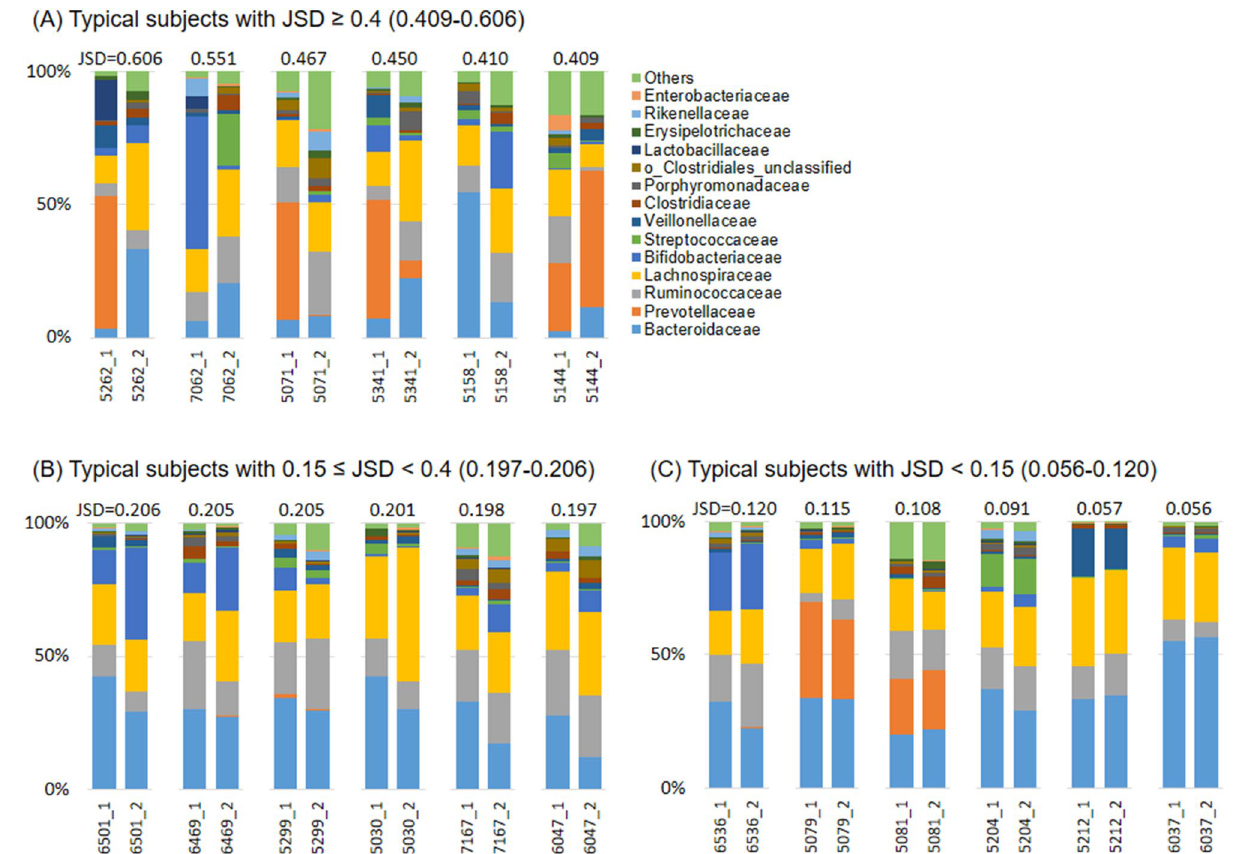
Figure 2. Changes of the predominant gut microbial composition at the family level between the first and second year. The subjects were classified into three groups by intra-individual Jensen-Shannon distance (JSD) range [( A ) JSD ≥ 0.4 (large), ( B ) 0.15 ≤ JSD < 0.4 (moderate) or ( C ) JSD < 0.15 (small variations in their gut microbiota between the 2 years)]. The 6 respective representatives are